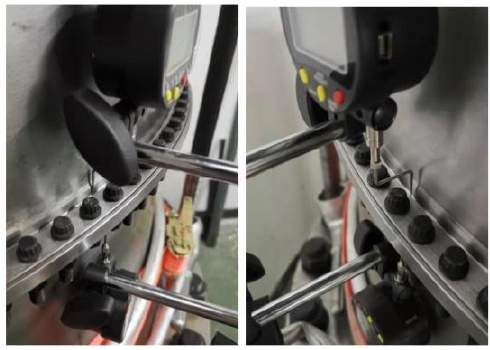
Figure 9. A dial indicator was used to measure the clearance between the two positions.